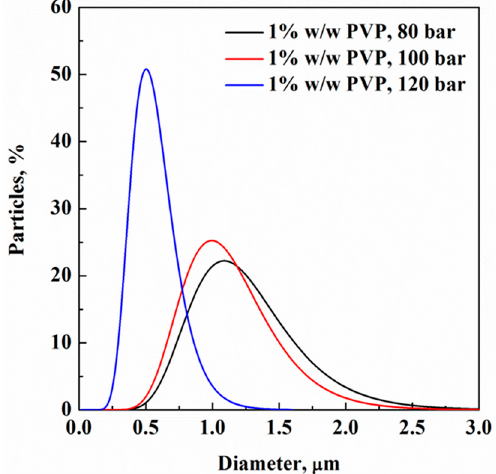
Figure 3. Particle size distributions (PSD) of 1% w/w PVP particles produced at different pressures.